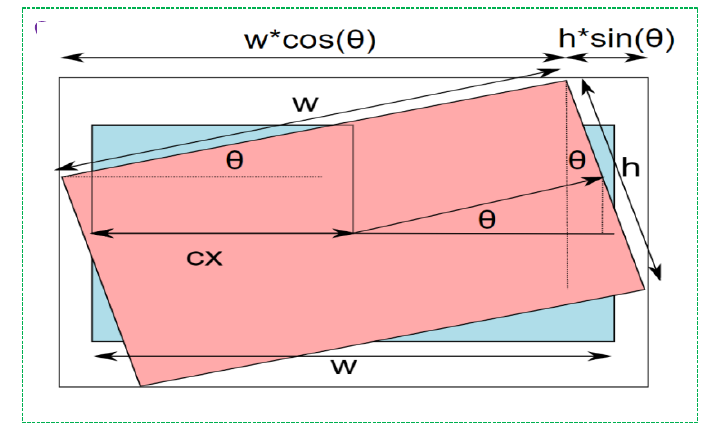
Figure 1. Image rotation schema.